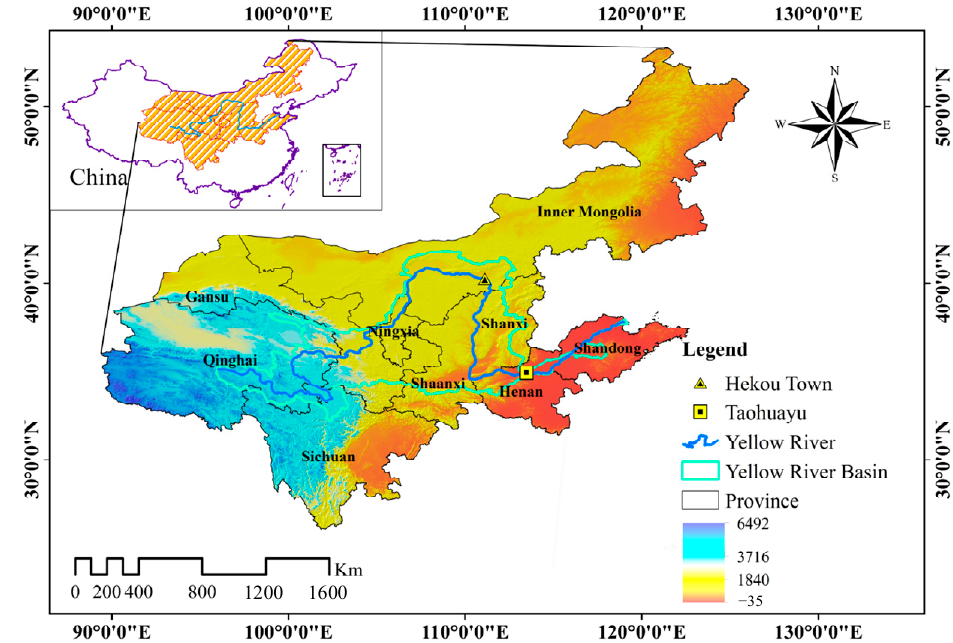
Figure 4. Geographical map of the Yellow River basin.